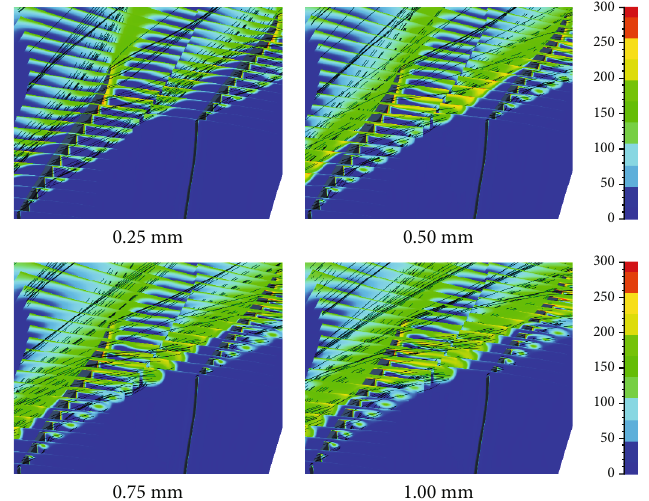
Figure 15: Contours of TCL streamlines and entropy near the blade tip of Rotor37.